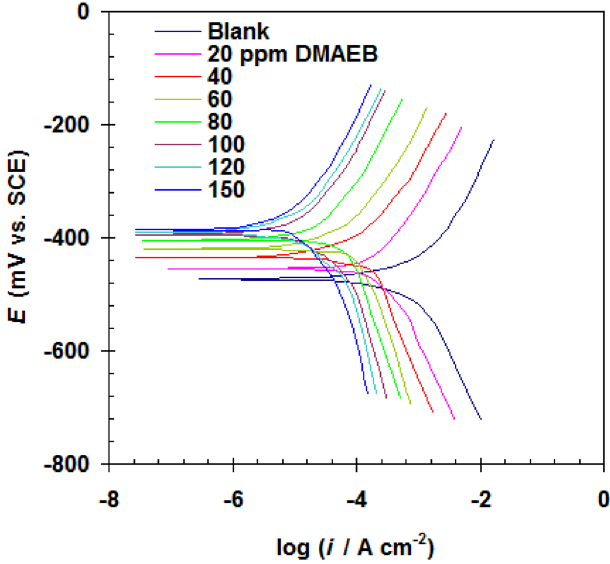
Figure 3. Polarization curves of N80 C-steel pipe in 15.0% HCl solution without (blank) and with DMAEB at 303 K.